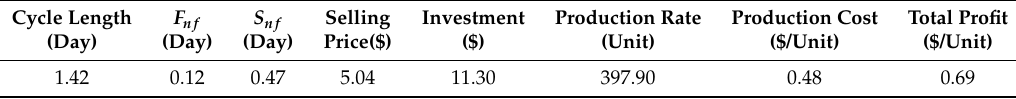
Table 4. Optimum result